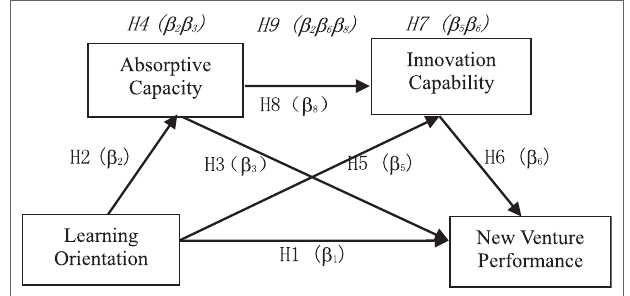
FIGURE 1 | Research model. Note: Italicized terms indicate mediating